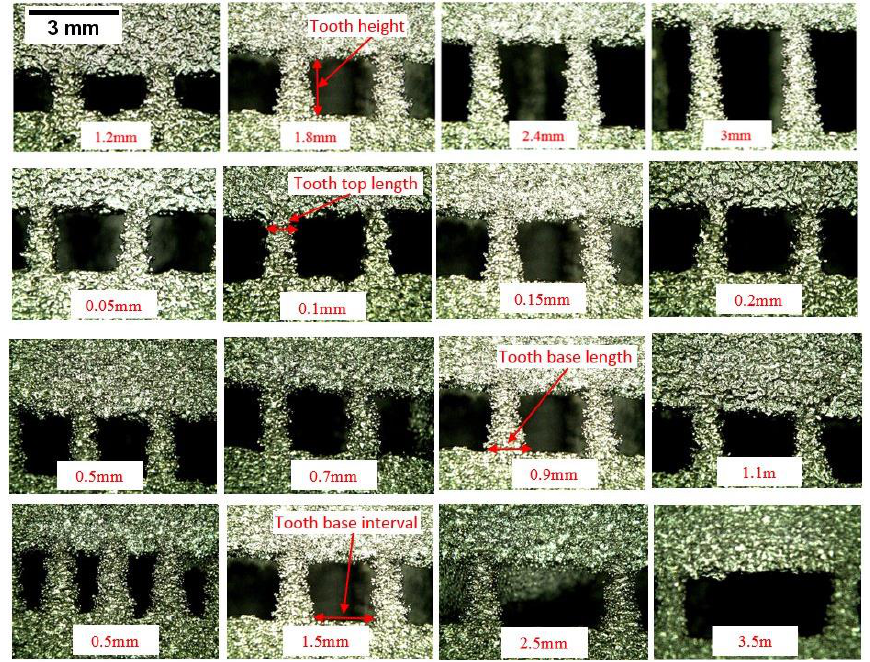
Figure 6. Support structure teeth parameters.